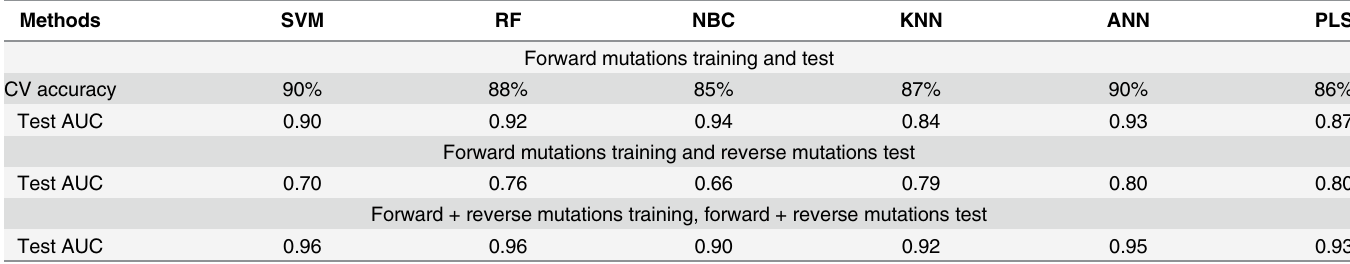
Table 12. ddG binary classification with forward and reverse mutations.